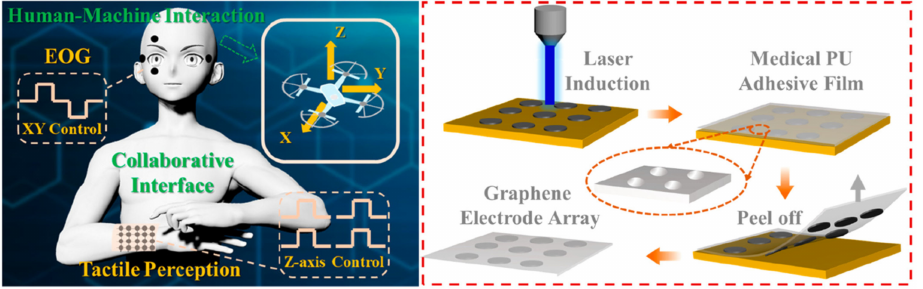
Figure 10. The EOG and tactile perception collaborated 3D HCI system. Reproduced with permission from [13]. Copyright 2022 American Chemical